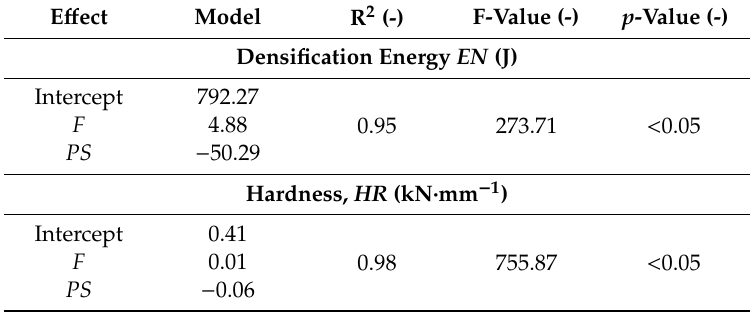
Table 11. Regression results of densification energy and hardness of the ground hazelnut husk briquettes with the e ff ects of force and particle size.